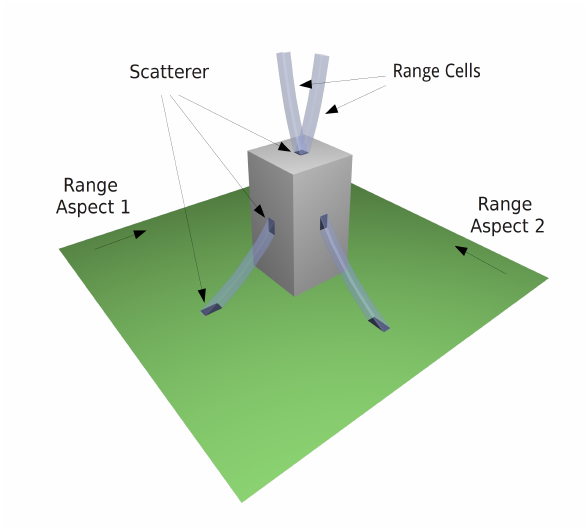
Figure 2: Three dimensional sketch of the intersection of mul- tiple elevation profiles from different aspects. Obviously both measurments share a common scatterer. This way the aspects are not independent from each other. The corresponding structure in terms of the graph topology is shown in Fig.